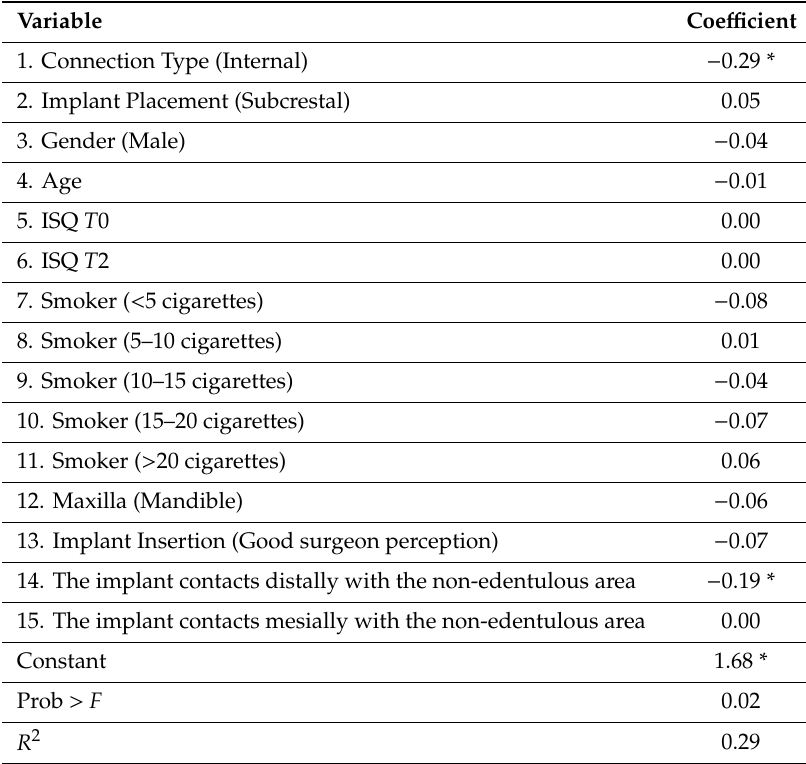
Table 4. Determinants of bone loss between T 0 and T 2.